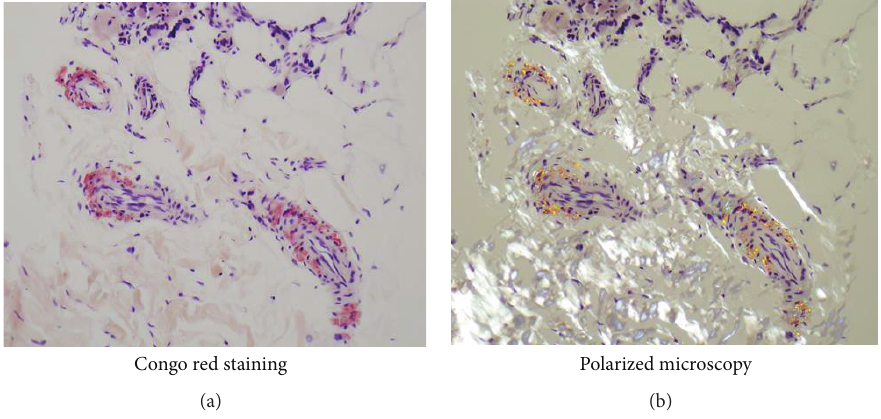
Figure 1: Perivascular and endomysial congophilic deposits on (a) H&E and (b) polarized